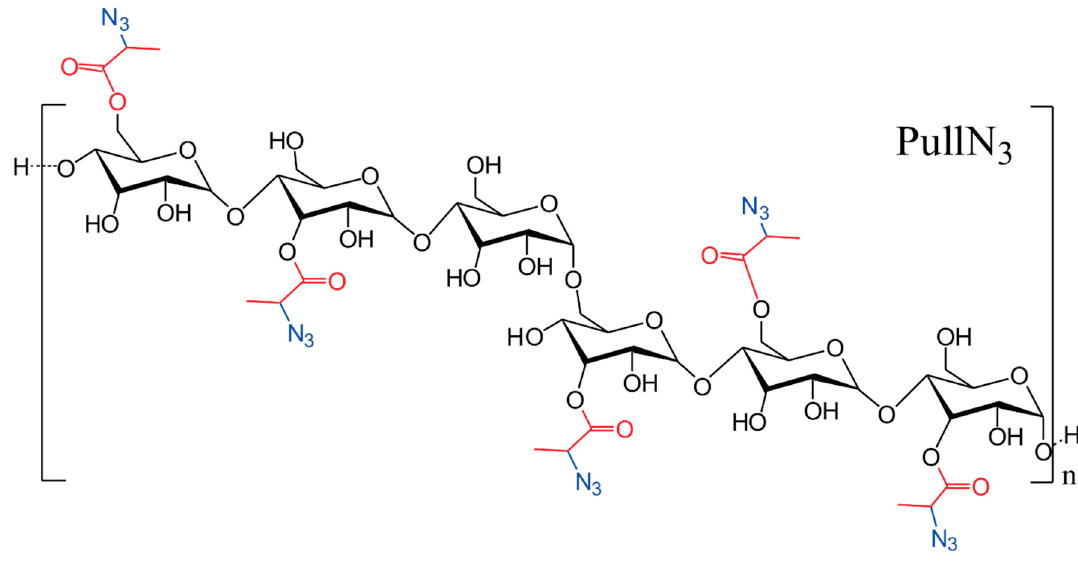
Figure 1. Chemical structure of PullN 3 used in this work.